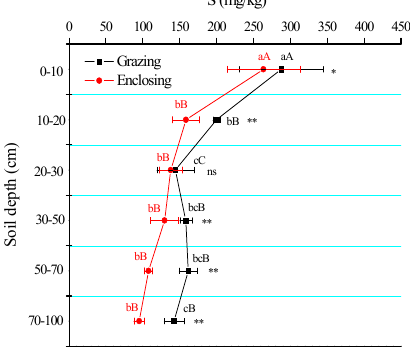
Figure 2. The effects of long term grazing and enclosing on soil contents of Ca, Mg and S. Note: * and ** indicate significant differences at p < 0.05 level and p < 0.01 level of Ca, Mg and S contents in each soil layer in the long term grazing plot and the long term enclosing plot and ns indicates no significant difference ( t test). Different lower case and capital letters indicate significant differences at p < 0.05 level and p < 0.01 level of Ca, Mg and S contents among different soil layers for the long term grazing or the long term enclosing by one-way analysis of variance (ANOVA). Error bars were one standard deviation.